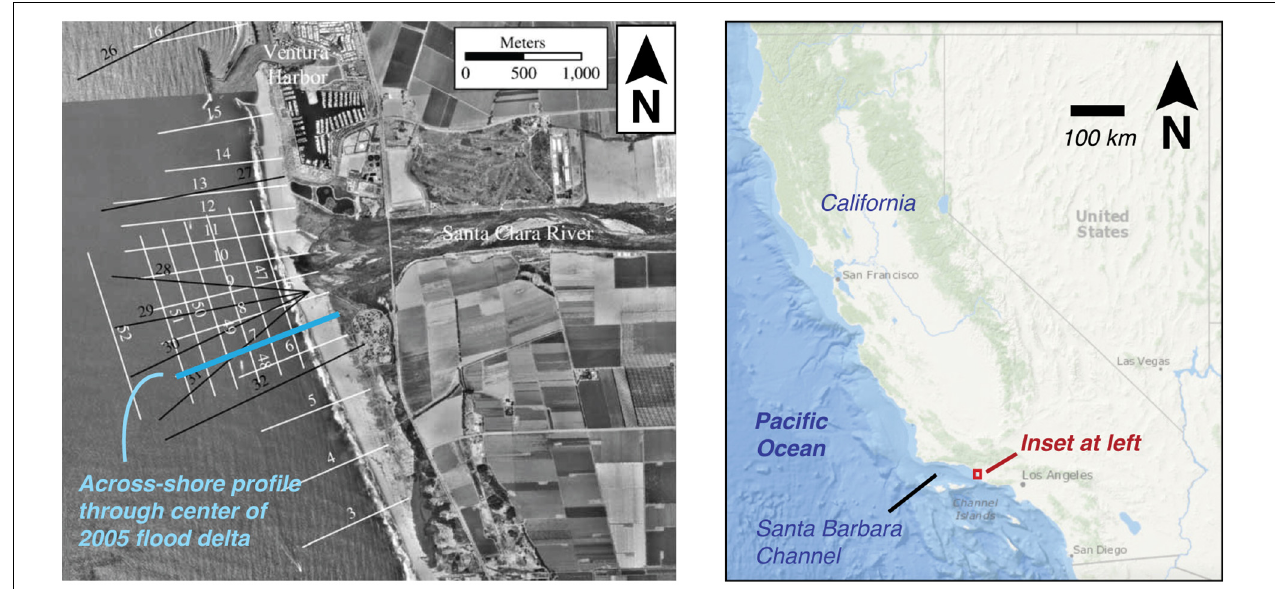
FIGURE 3 | Topographic and bathymetric profile surveys lines for the Santa Clara River mouth of California (34.232 ◦ N, 119.264 ◦ W) collected between 2003 and 2010 and used for analyses. The highlighted profile (number 7) is located down the axis of the deltaic lobe of sediment deposited in January 2005 (cf. Figure 1 ), and data from it was used for